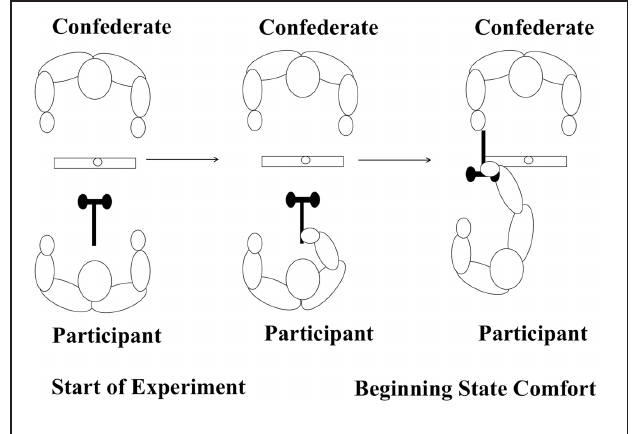
FIGURE 1 | Participants grasping and turning the hammer (placed in a comfortable position relative to the participant) to give the confederate beginning-state